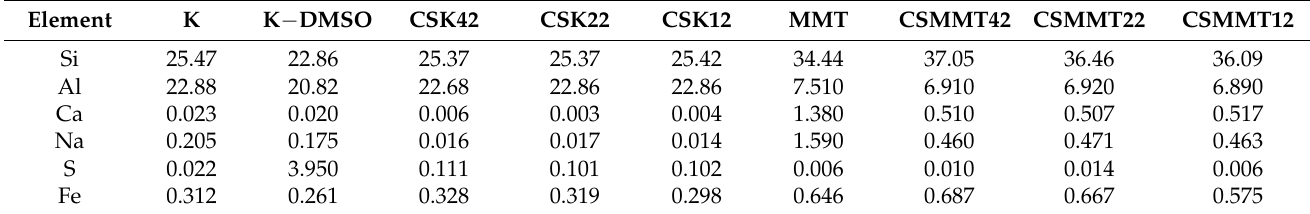
Figure 3. Zeta potentials of CS, K, K − DMSO, CSK42, CSK22, CSK12, MMT, CSMMT42, CSMMT22, and CSMMT12. Data represent the mean ± SD ( n = 3). Table 1. Elemental composition of K, K − DMSO, CSK42, CSK22, CSK12, MMT, CSCMMT42, CSMMT22, and CSMMT12 (wt